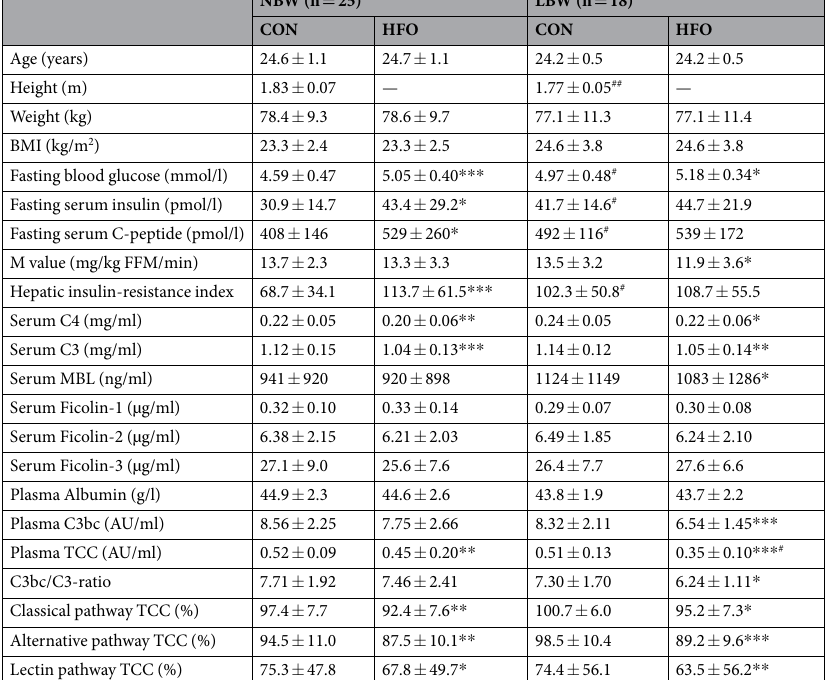
Table 1. Subject characteristics of NBW and LBW subjects (CON) and after high-fat overfeeding (HFO). Data are means ± SD. AU, arbitrary units; CON, control diet; HFO, High-fat overfeeding; TCC, terminal